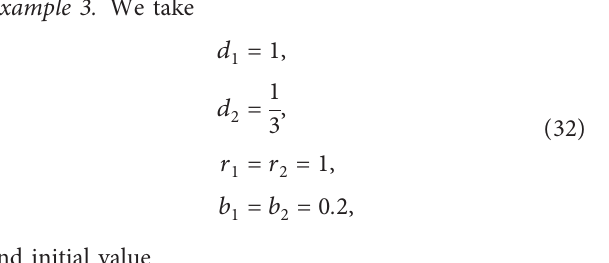
( x, t ) (green line) and u 1